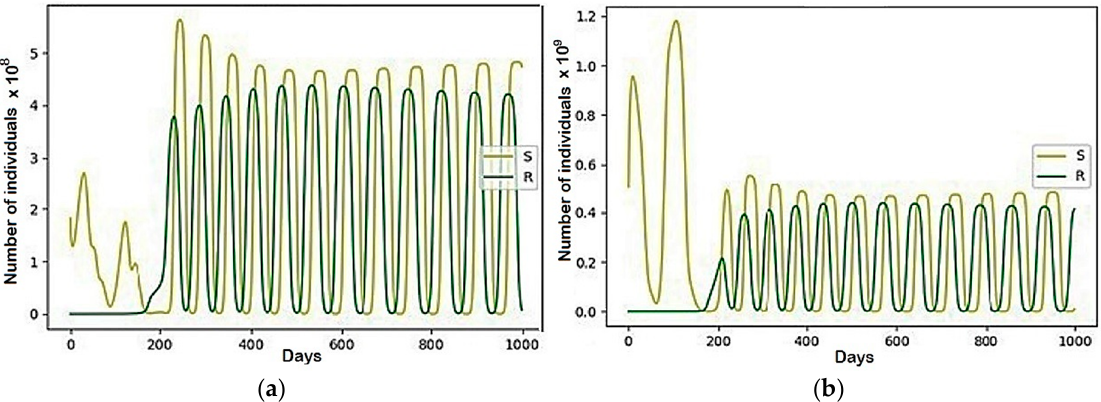
Figure 9. A scenario in which a 1 = 1, b 1 = − 0.1, b 4 = 0.05, c 1 = − 0.15, c 4 = 0.1, d 1 = − 0.3, d 2 = − 0.7, and the rest are equal to zero: ( a ) Region 1; ( b ) Region 2; ( c ) Region 3; ( d ) Region 4.